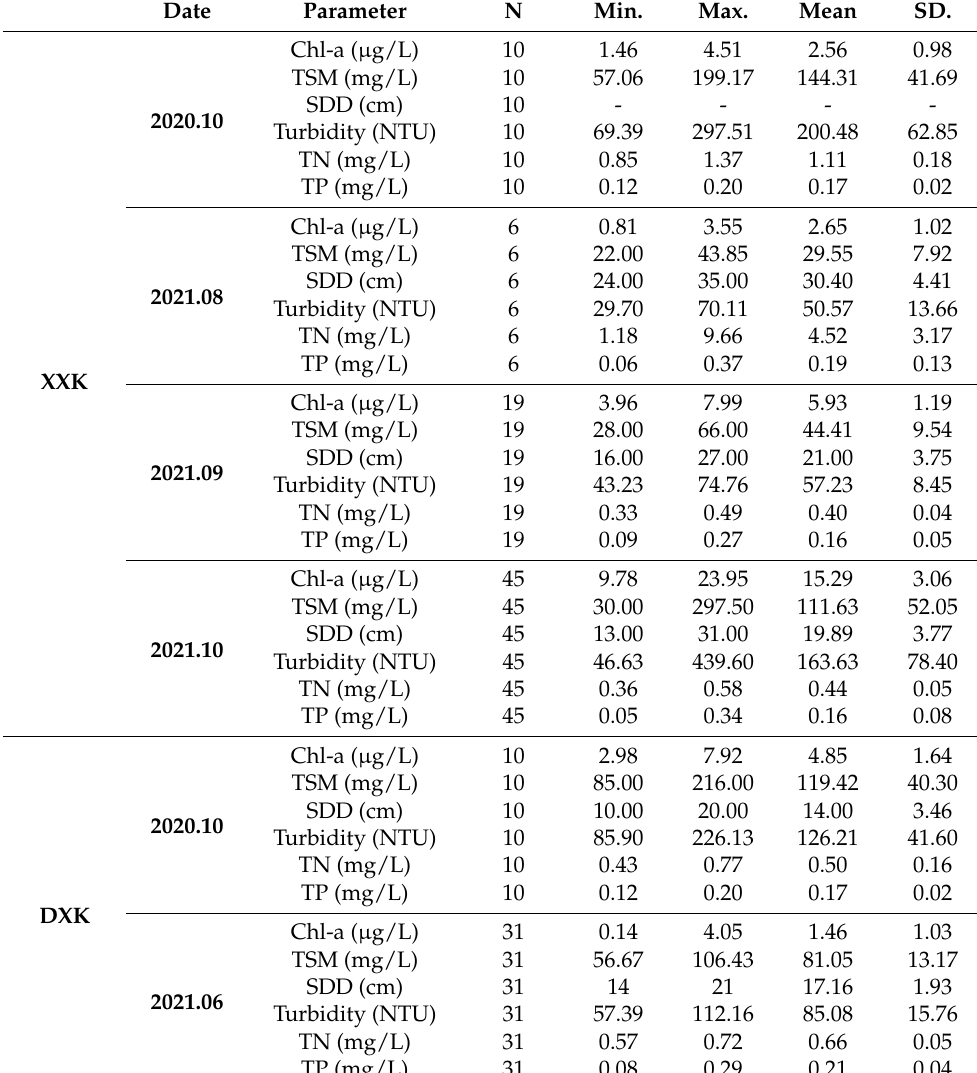
Table 1. The statistical description of water quality parameters in Xiao Xingkai (XXK) and Da Xingkai Lake